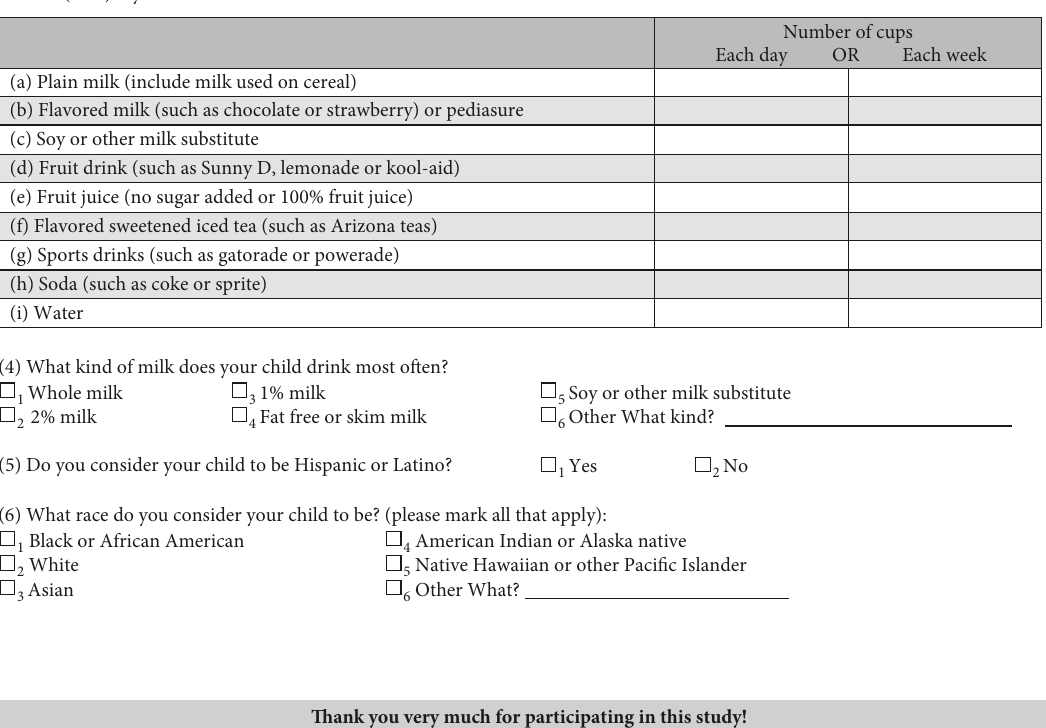
Figure 1: Questions from the larger instrument used for data collection included in this